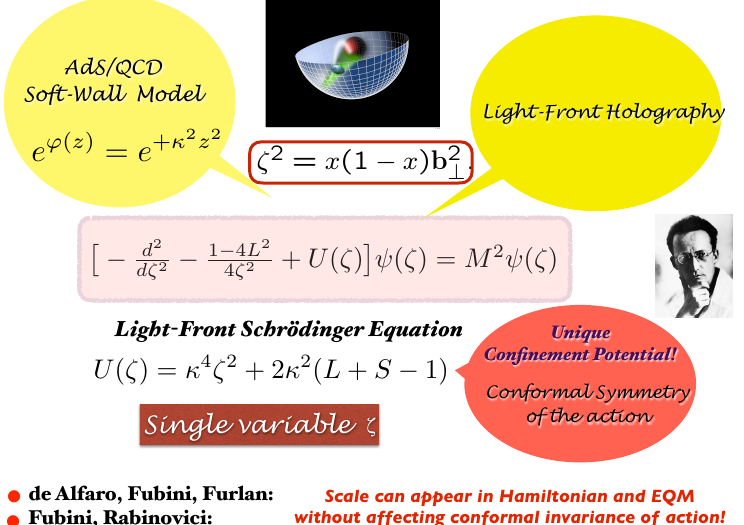
Figure 1. The convergence of theoretical methods for generating a model of hadron spectroscopy and dynamics with color confinement and meson-baryon supersymmetric relations. Nonzero quark masses appear in the “LF kinetic energy" (LFKE) ∑ i